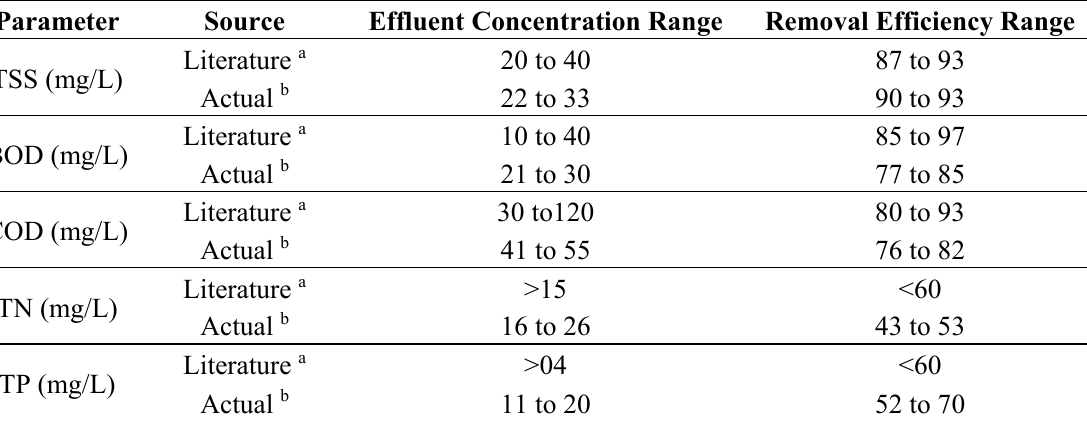
Table 2. Comparison of averaged observed and actual values of effluent concentration removal